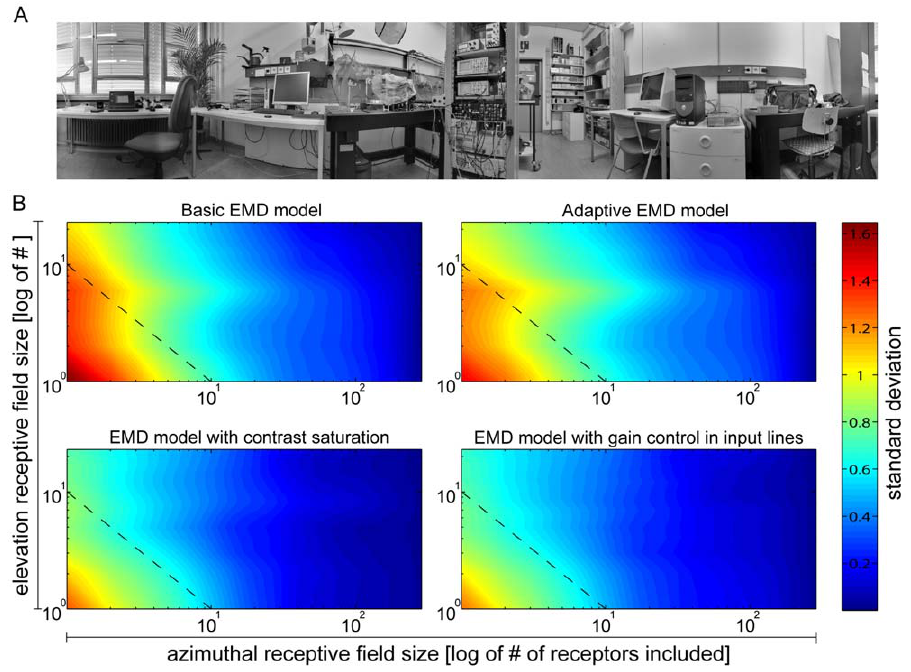
Figure 5. Pattern-dependent modulations of EMD models with two-dimensional receptive fields. (A) Panoramic high dynamic range input image used exemplarily for stimulation. (B) Color coded standard deviation describing the mean pattern-dependent modulation for two- dimensional receptive field arrays for all models. Receptive field size is defined via the number of receptors included in the integration of EMD signals in elevation and azimuth. Two-dimensional receptive fields are achieved by expansion of a one-dimensional receptive field located at the center of horizon in its vertical and horizontal size. The iso-line describes exemplarily receptive field sizes with 10 receptors included. The cross corresponds to a square receptive field (m=n) with 256 receptors included.